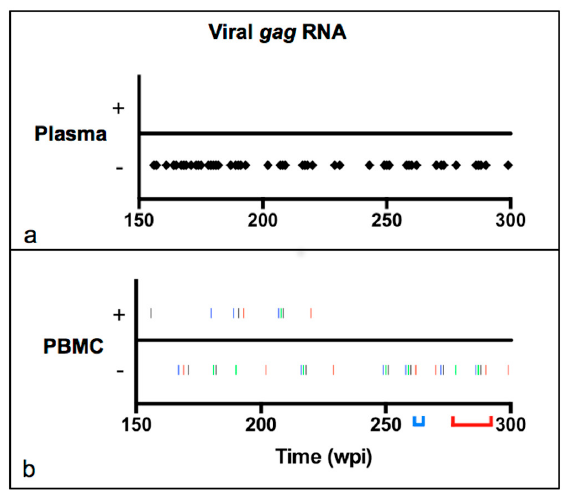
Figure 1. Plasma and PBMC-associated viral gag RNA in asymptomatic FIV-infected cats over time. ( a ) Viral gag RNA was undetectable by real-time PCR assays in the plasma of all four FIV-infected cats for the entire study period (150–300 weeks post-inoculation, each diamond represents a single plasma sample from an individual FIV-infected cat) and rarely, but intermittently detected in PBMCs between 150 and 220 wpi; ( b ) Viral gag RNA was intermittently detectable in the first half of the study period and undetectable in PBMCs between 220 and 300 wpi. Viral gag RNA was undetectable in both plasma and PBMCs during the periods that abundant short proximal promoter R-transcripts were amplified (blue bracket, 258–262 wpi) and the popliteal lymph nodes were surgically removed (red bracket; 274–290 wpi). Black = cat 187, blue = 184, red = 165, green = 186. Table 1. Real-time PCR amplifications of viral gag and short promoter R-segment cDNA isolated from